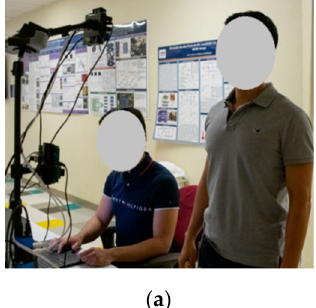
Figure 9. The signal processing pipeline used in the practical testing to classify the subjects and validate the data. The process starts by an input from the operator using MATLAB by running the two scripts, one on each laptop, which will then start the loop scanners. The loop scanners will monitor the radar’s output folders continuously and move the raw data files to a shared folder that is accessible to the two laptops. Additionally, the gait scanner, also called secondary scanner, will store the last four files, each corresponding to a recording time of three seconds, which results in total storage time of 12 s. Conversely, the heart sound scanner, also called the primary scanner, will store only one raw data file at a time corresponding to 10 s. During those loops, the primary scanner will check the scan files for a stationary target 50 cm away from the platform. If the target is detected, the primary scanner will issue a flag that will trigger the two classifiers. Then, the primary scanner will use the same scan to extract the heart sound biometric. Additionally, the secondary scanner will pick the least recent scan file corresponding to the time when the subject was walking towards the platform. Subsequently, the classifiers will process the data as explained in Sections 2.1 and 2.2 to produce two images that can be fed to the trained neural networks. The neural networks will then classify the images independently and produce two outputs per each image. One output will return the name of the predicted class (i.e., name of the subject), while the other, in the form of a matrix, will return the prediction score, P, for each class. After that, the primary scanner will check the results to determine if the prediction scores for the predicted subjects are higher than 50%. If the condition is satisfied, the results are combined using the joint PMF method, as explained in Section 2.5, and the predicted subject is returned to the user with a successful detection mark. On the other hand, if any of the two predictions has a prediction score